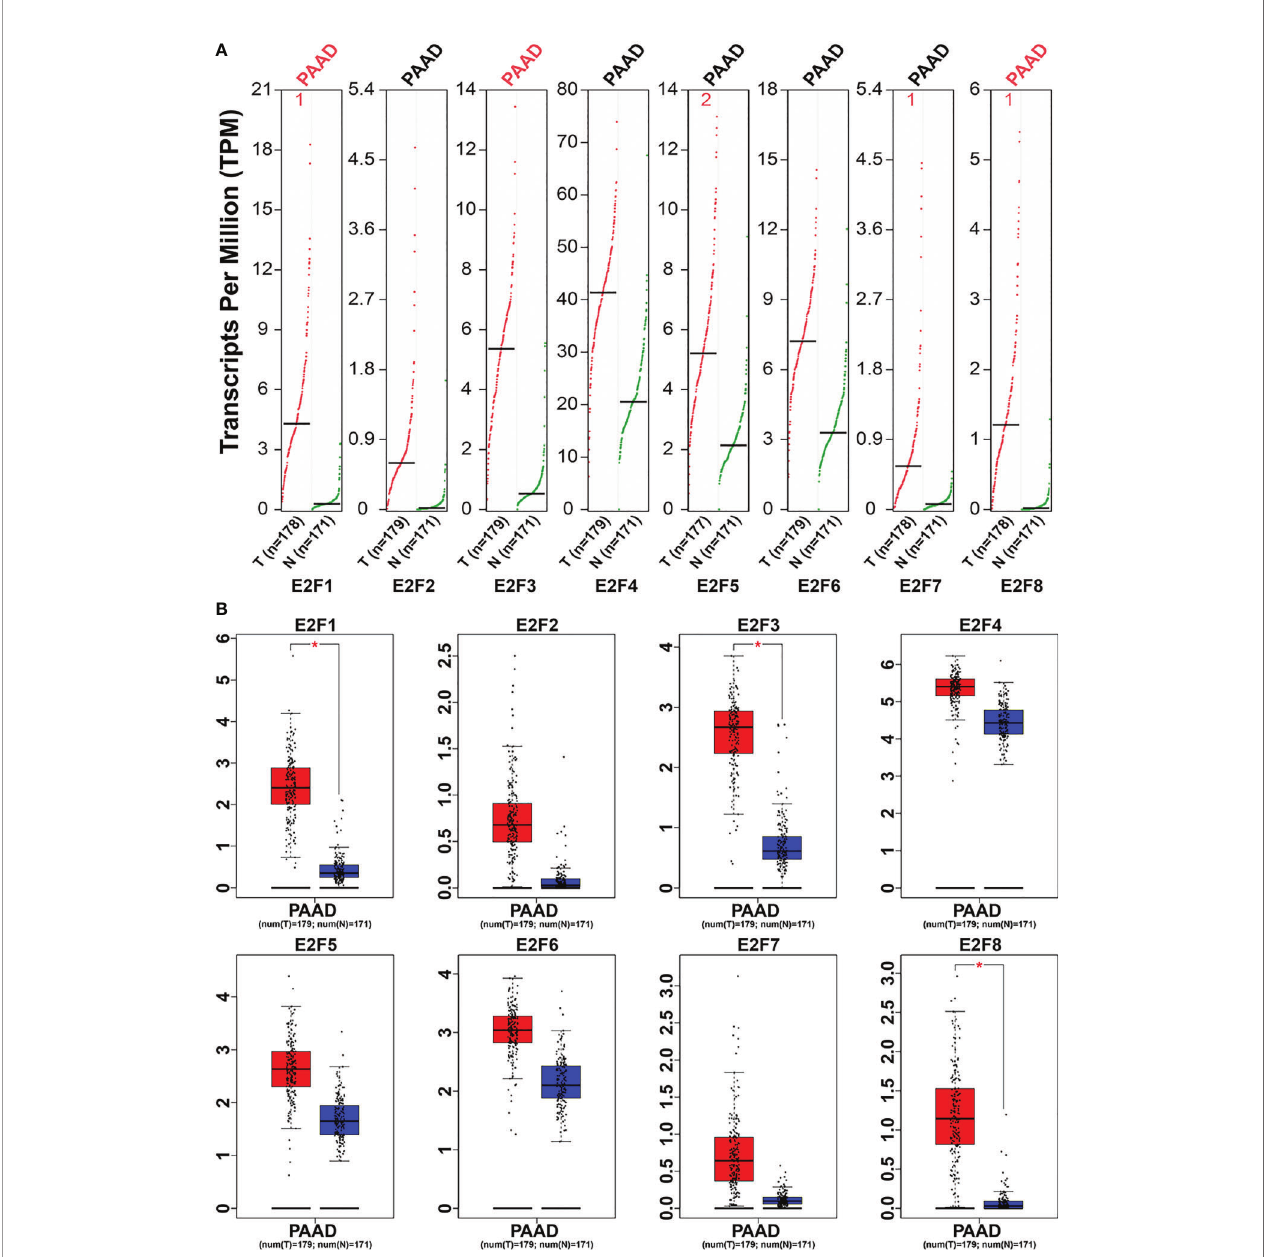
FIGURE 2 | The expression of E2Fs in PAAD